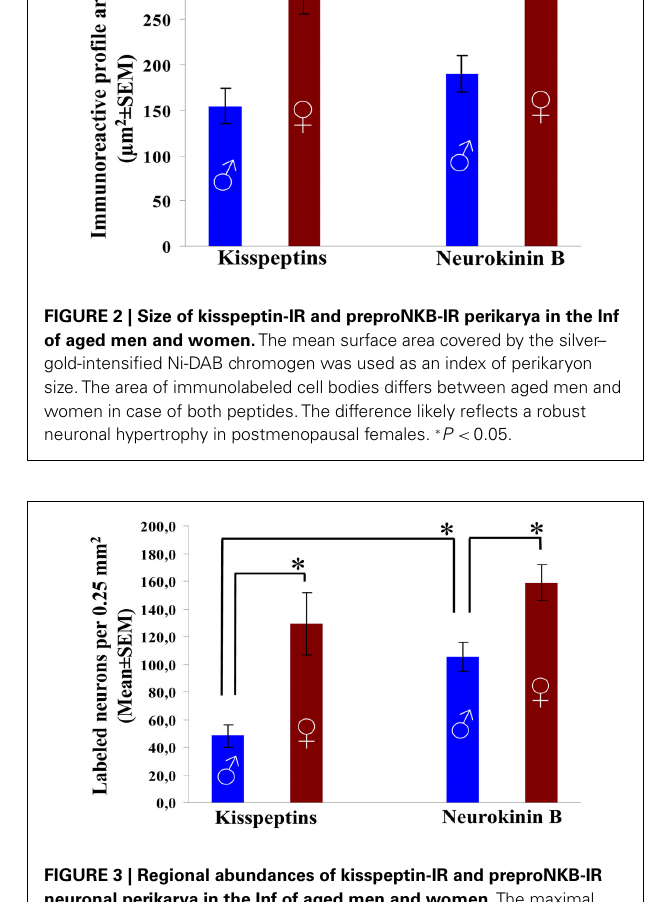
FIGURE 3 | Regional abundances of kisspeptin-IR and preproNKB-IR neuronal perikarya in the Inf of aged men and women. The maximal number of immunoreactive cell bodies per 0.25mm 2 counting frame (1–6 per subject) was determined with the aid of an ocular frame and used